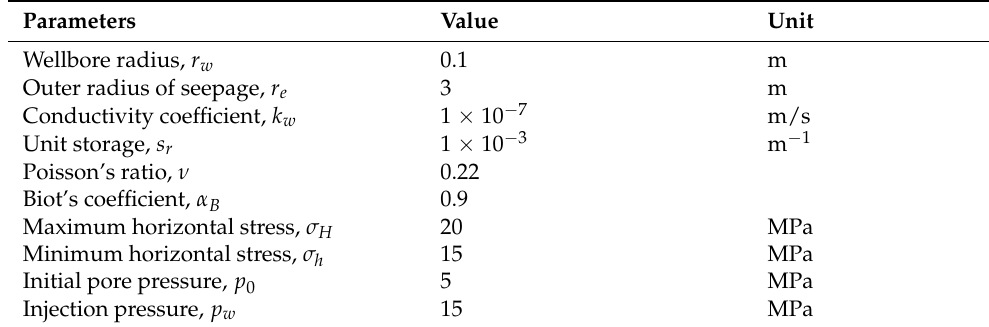
Table 4. Parameters employed in comparison with the model (Zhou et al., 2021) [36].